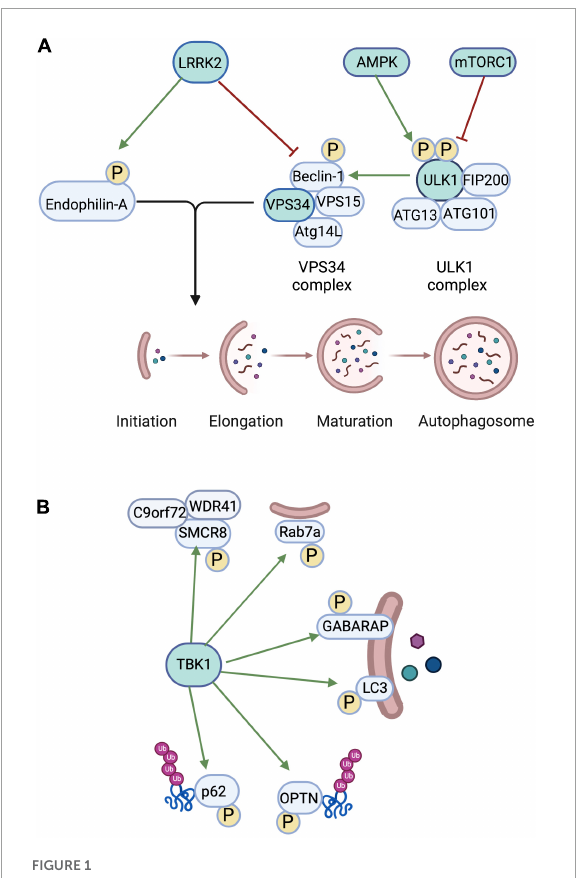
FIGURE1 Role of autophagic kinases in regulating autophagy. (A) The autophagic kinase AMPK phosphorylates ULK1 to activate autophagy, while mTORC1 phosphorylates ULK1 to inhibit autophagy. ULK1 then phosphorylates Beclin-1 in the